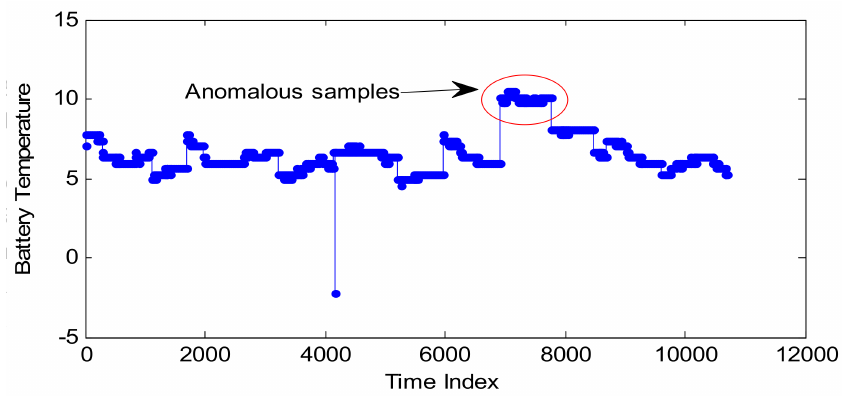
Figure 13. Battery temperature series with anomalous